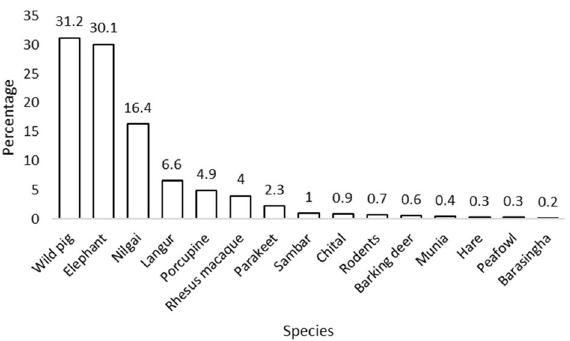
Figure 1. Percentage of respondent reported wild animals involved in crop raiding around the forest corridor linking the Rajaji and Corbett Tiger Reserves, Uttarakhand, India.